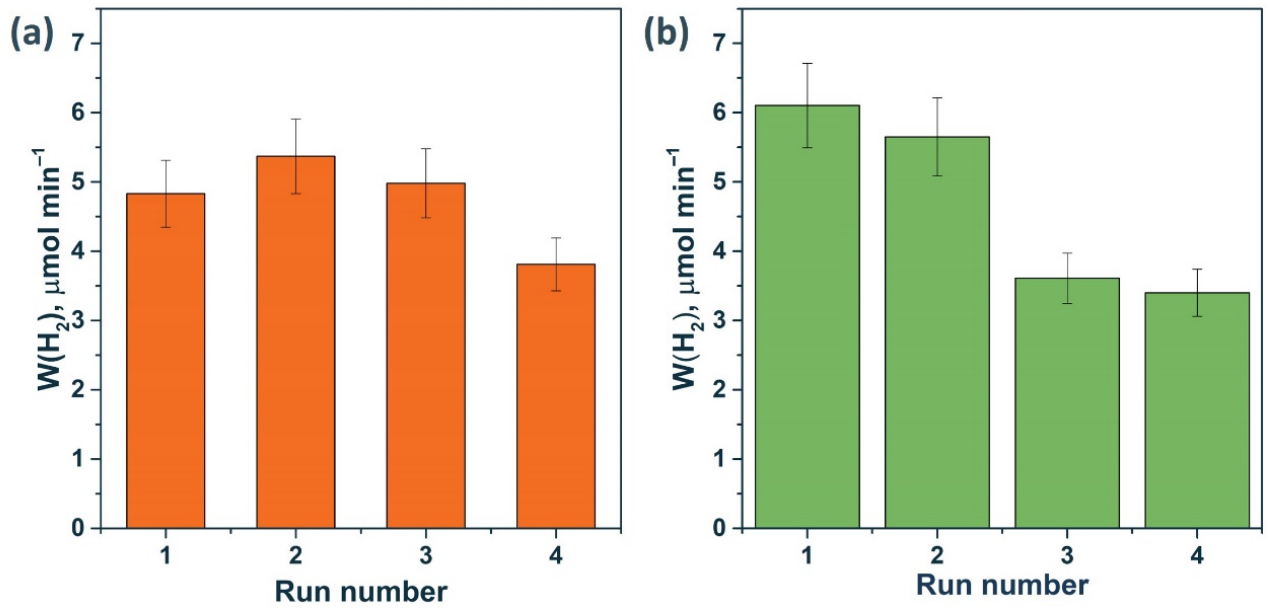
Figure 11. Stability test of photocatalysts ( a ) 0.5% NiS/Mn0.6 HT120 and ( b ) 1% Pt/Mn0.6 HT120. Experimental conditions: C 0 (glucose) = 0.012 M, C 0 (NaOH) = 0.1 M, m cat = 50 mg, V susp = 100 mL, λ = 425 nm, and t run = 90 min.